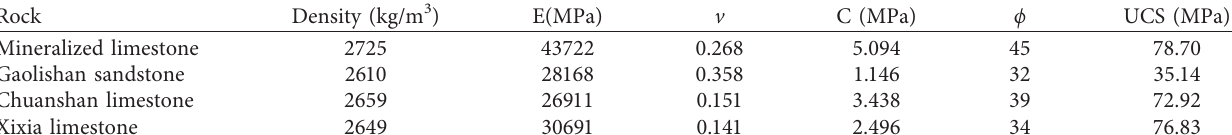
Table 1: Material properties of